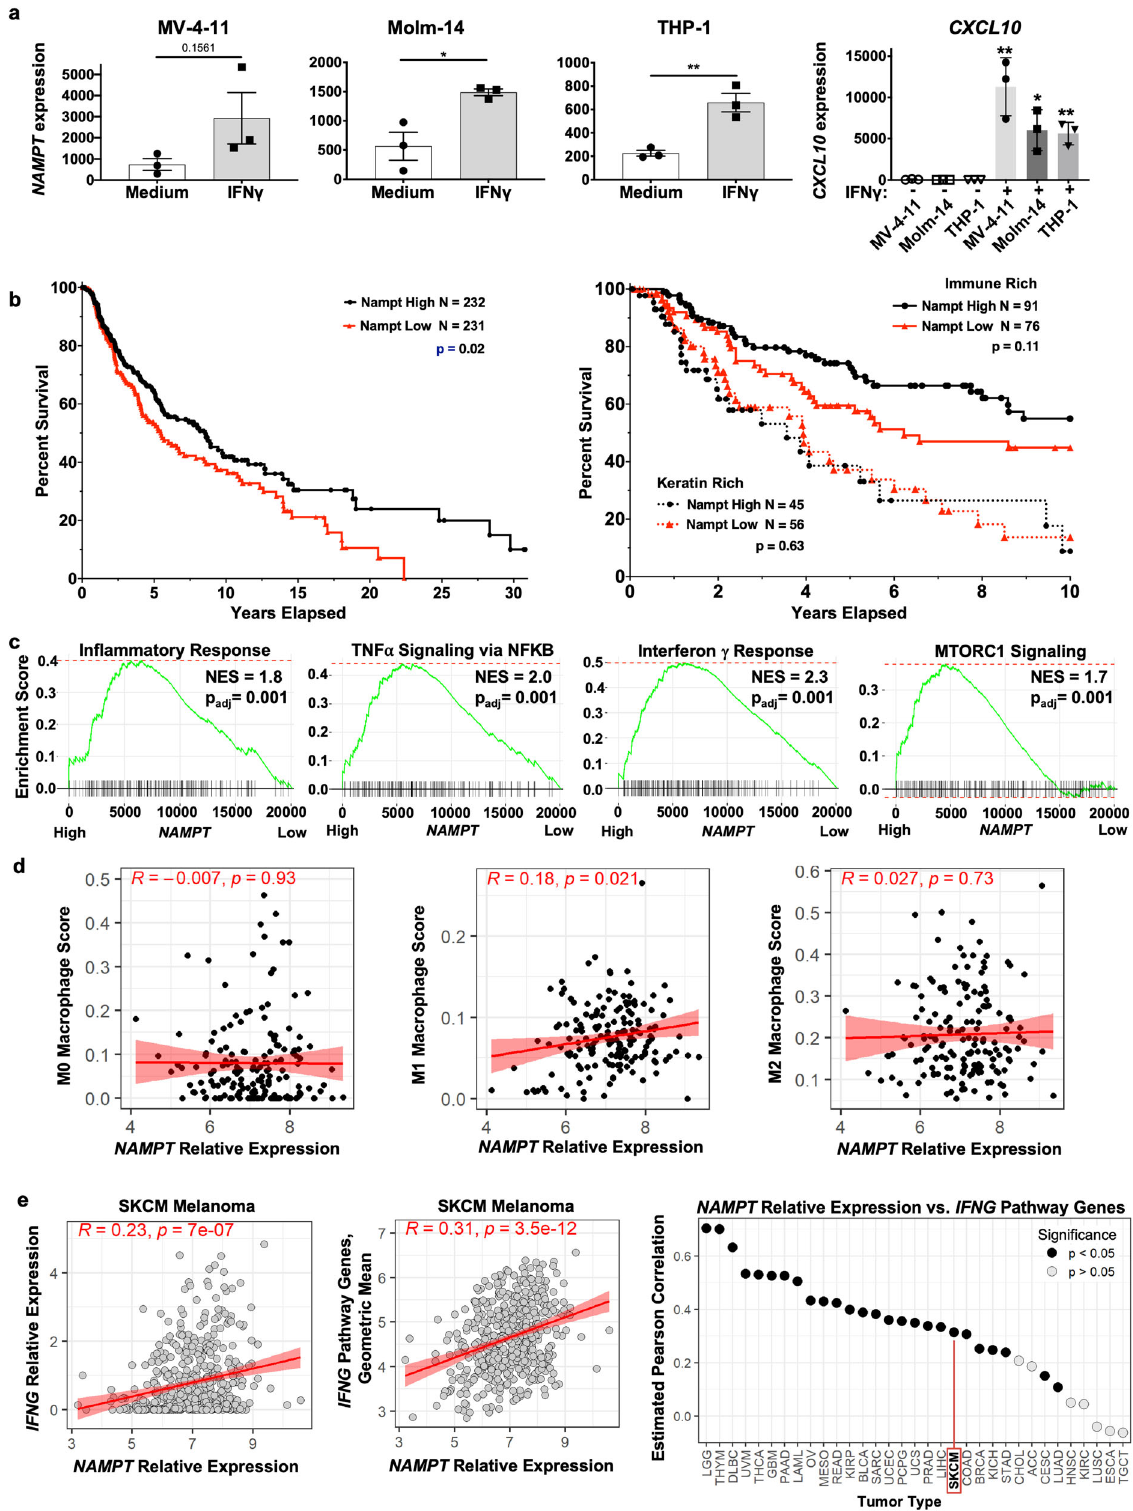
macrophage lineage-speci fi c ablation of NRE1 instead used females carrying the LysM-Cre driver heterozygous with the WT Lyz2 (LysM) allele. Mice were sex and age matched in each individual experiment, in vivo studies used females, and ages ranged from 6 to 10 weeks old. Mouse vivarium housing conditions are maintained with a 12-h light/dark cycle per day, temperature of 22°C, and 20% relative humidity. All housing, husbandry, and experimental procedures using mice were performed with the approval of